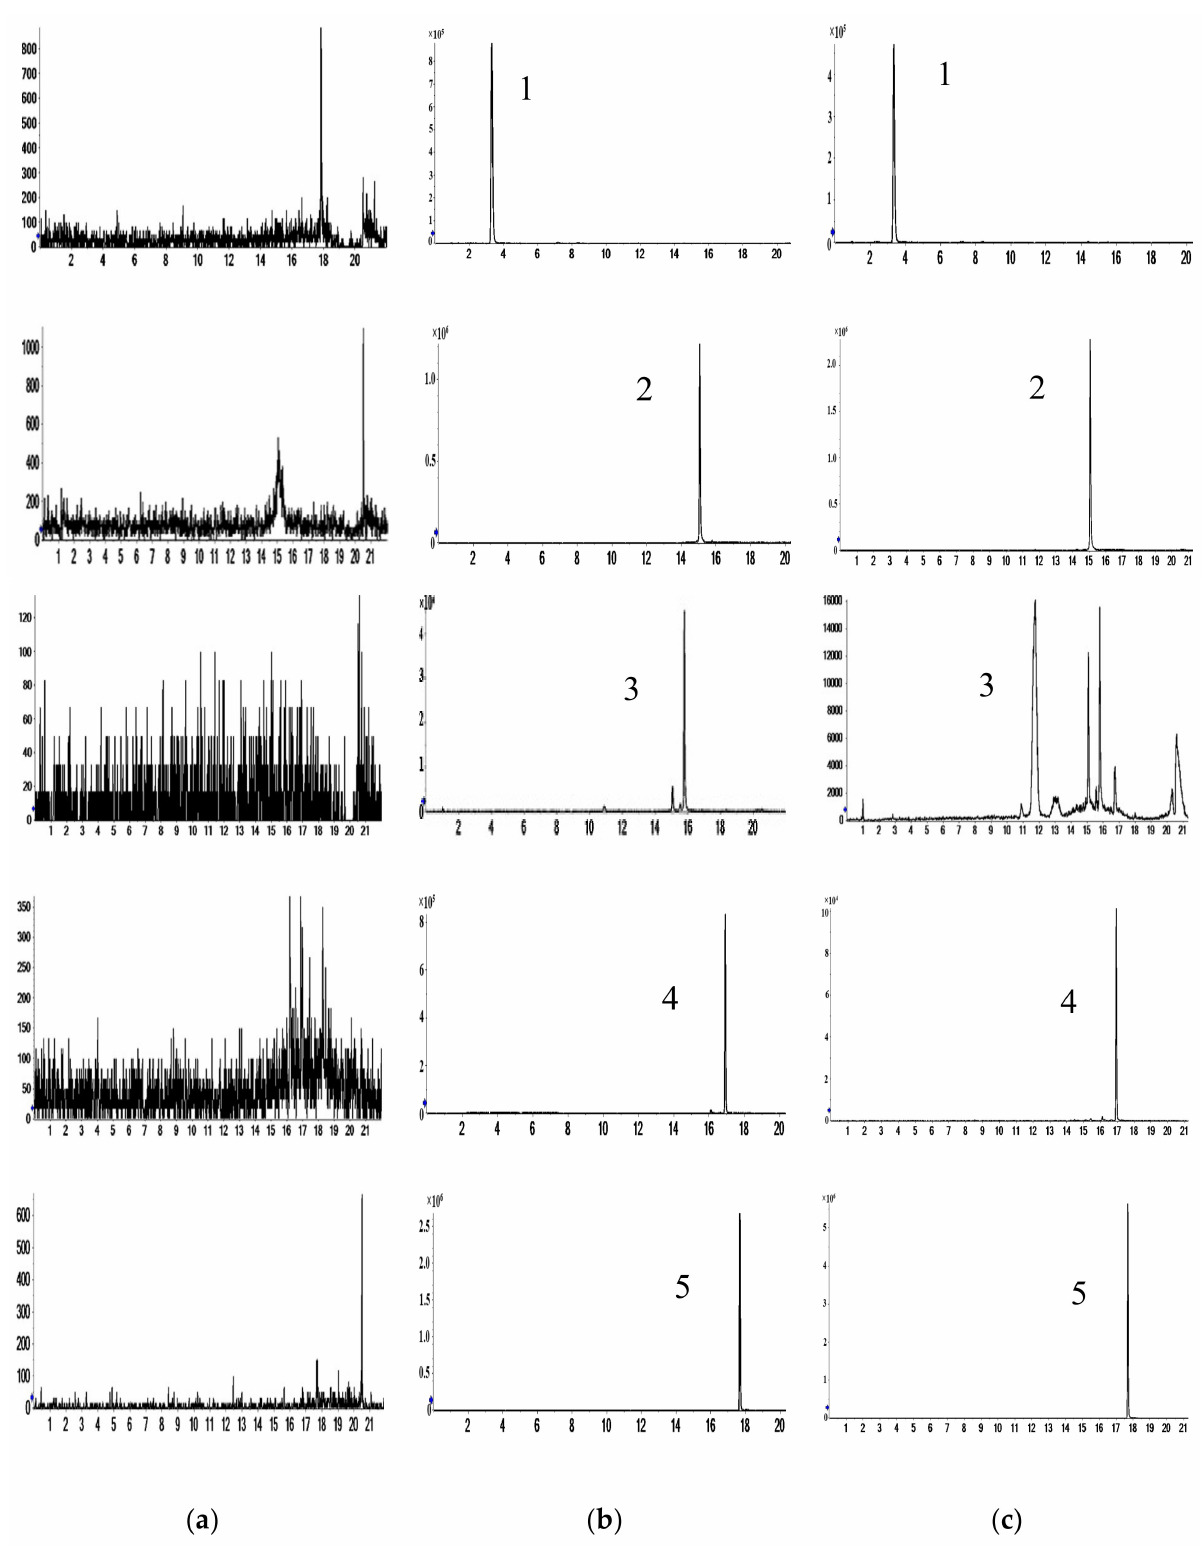
Figure 13. Representative MRM chromatograms of analytes in different samples. ( a ) Blank plasma; ( b ) blank plasma + reference substance+IS; ( c ) plasma samples after oral administration of the aerial parts of G. uralensis for 4 h. (1) Puerarin; (2) luteolin; (3) kaempferol; (4) pinocembrin; (5) IS